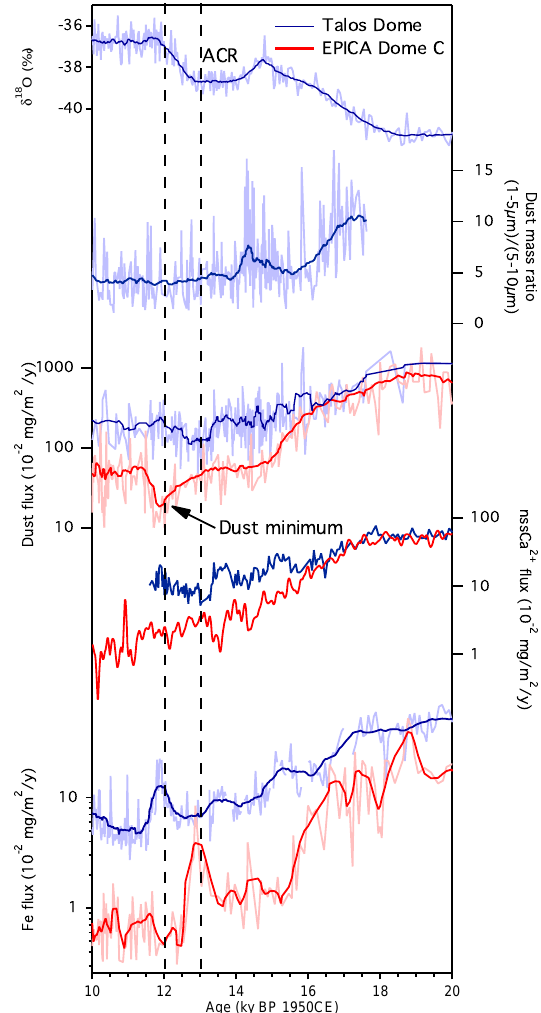
Fig. 1. Talos Dome Fe (this work) and dust (Delmonte et al., 2010) fluxes and δ 18 O (Stenni et al., 2011) compared to Fe (Wolff et al., 2006) and dust (Lambert et al., 2008) fluxes at EPICA Dome C. All dust concentrations were determined by coulter counter. CO 2 concentrations were compiled from various Antarctic ice cores for the period 0.2–138kyrBP (Schilt et al., 2010) and from EDC be- fore 138kyrBP (L¨uthi et al., 2008). Thick lines show various box smoothing filters that have been applied to EDC dust fluxes (11pt, 0–200kyrBP) and Talos Dome δ 18 O data (15pt, 0–200kyrBP), Fe/dust ratios (19pt, 0–70kyrBP), dust fluxes (11pt, 0–70kyrBP) and Fe fluxes (19pt, 0–80kyrBP; 9pt, 80–200kyrBP).